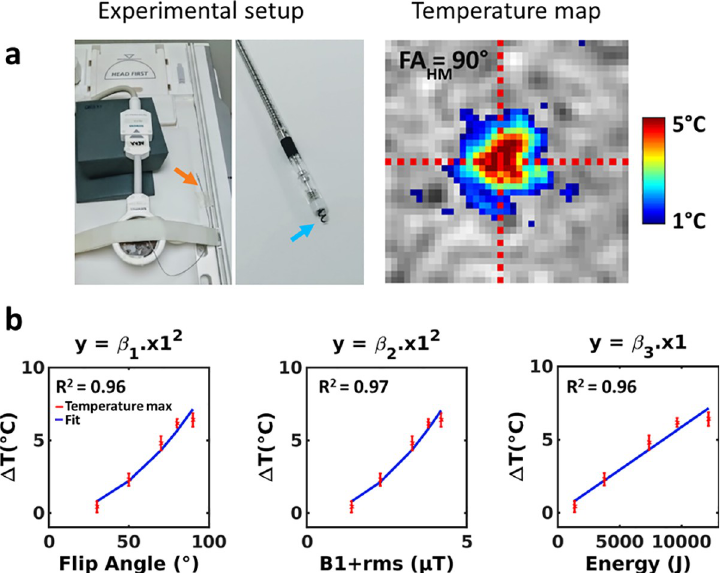
Fig 6. Application of the proposed method on a pacemaker lead. (a) Experiments on a MR conditional pacemaker lead inserted into a gel. Left: photographs of the setup showing the position of the gel and lead on the MRI table (orange arrow indicates the position of the extremity of the lead, blue arrow indicated the tip screwed into the myocardium). Right: temperature image at dynamic acquisition #90 for a 90˚ flip angle of the heating module. (b) Calibration curves obtained for a series of measurements with flip angles of 30˚, 50˚, 70˚, 80˚ and 90˚. Coefficients resulting from a quadratic fit were β 1 = 8.8 ± 0.5.10 − 4 ˚C/˚ 2 , β 2 = 0.4 ± 0.02˚C/( μ T) 2 and coefficient resulting from a linearly fit was β 3 = 5.8 ± 0.3.10 − 4 ˚C/J.